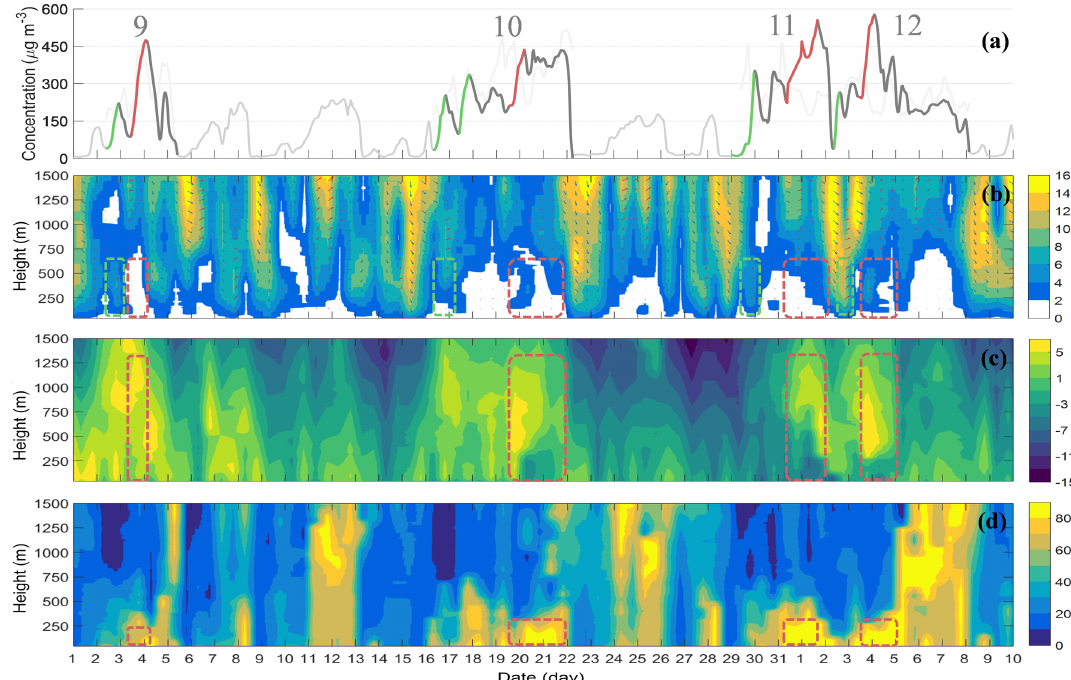
Figure 4. Temporal variations in urban mean PM 2 . 5 and vertical distributions of meteorological factors in December 2016. (a) PM 2 . 5 mass concentration (dark gray or gray: Beijing; light gray: Baoding); (b) winds (vectors; red vectors: southwesterly winds) and wind velocity (shadings; units: ms − 1 ); (c) temperature (shadings; units: ◦ C); (d) RH (shadings; units: %). Green boxes: rising processes; red boxes: cumulative explosive